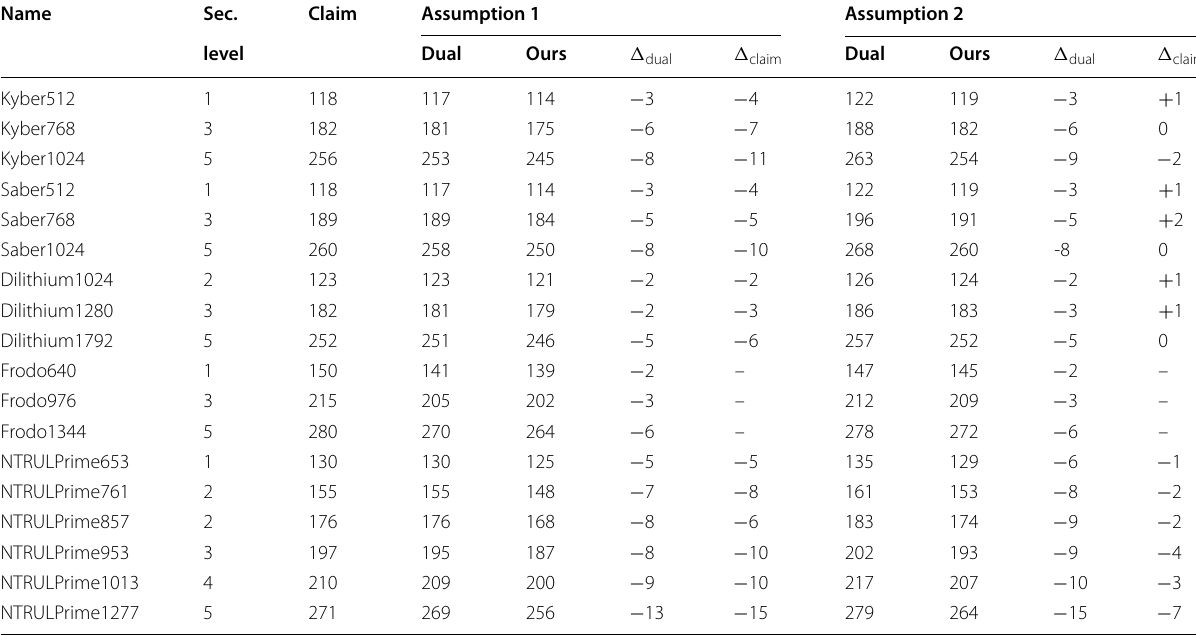
Table 2 Bit-security estimations under Core-SVP